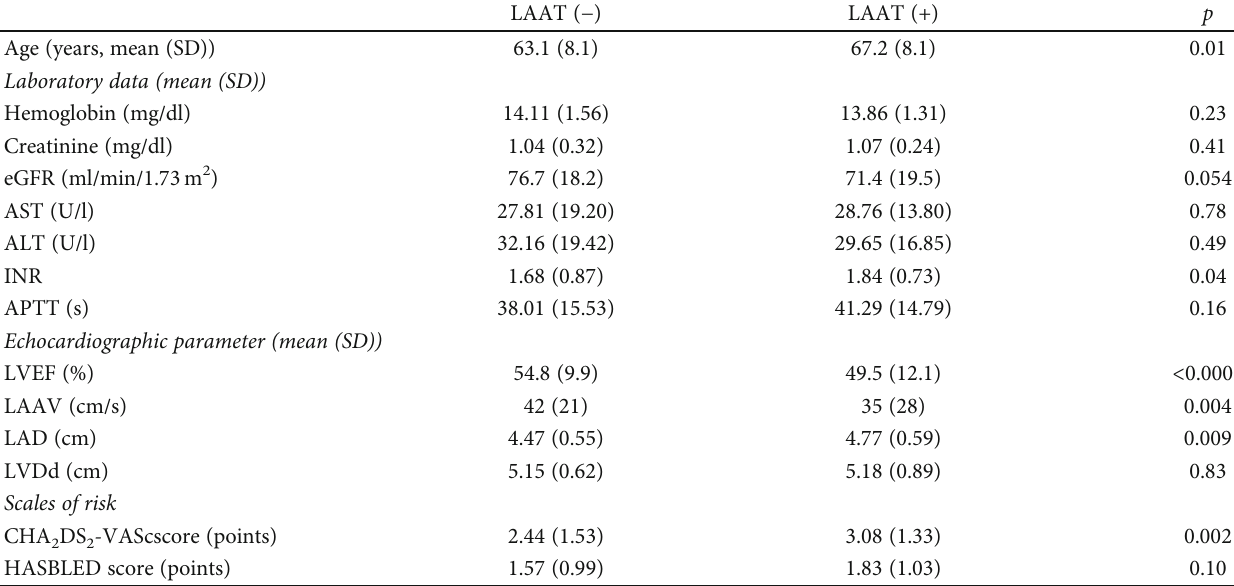
Table 3: Comparison of baseline characteristics between patients with (LAAT (+)) and without (LAAT ( − )) left atrial thrombus.